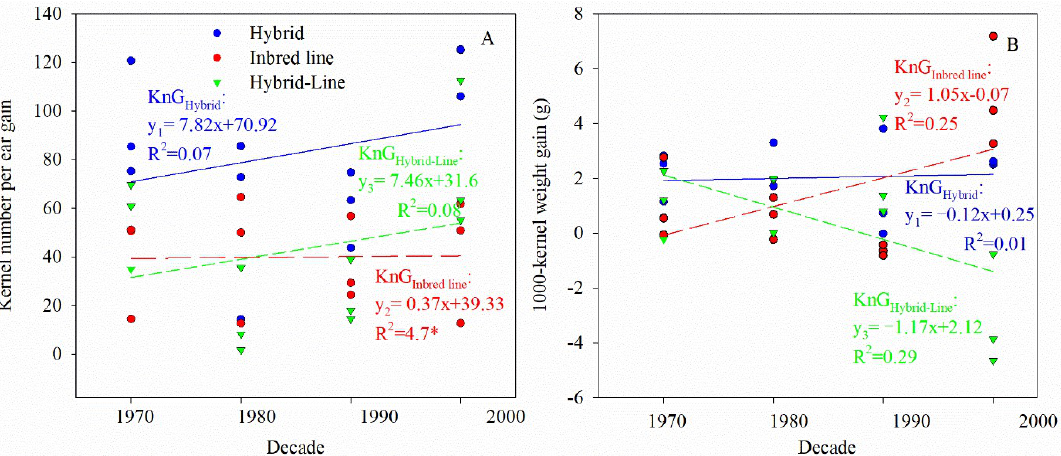
Figure 1. Changes of KnG and KwG of maize hybrids and inbred lines in different decades. Note: ( A ), Kernel number per ear gain; ( B ), 1000-kernel weight gain. * indicate significant differences at 0.05